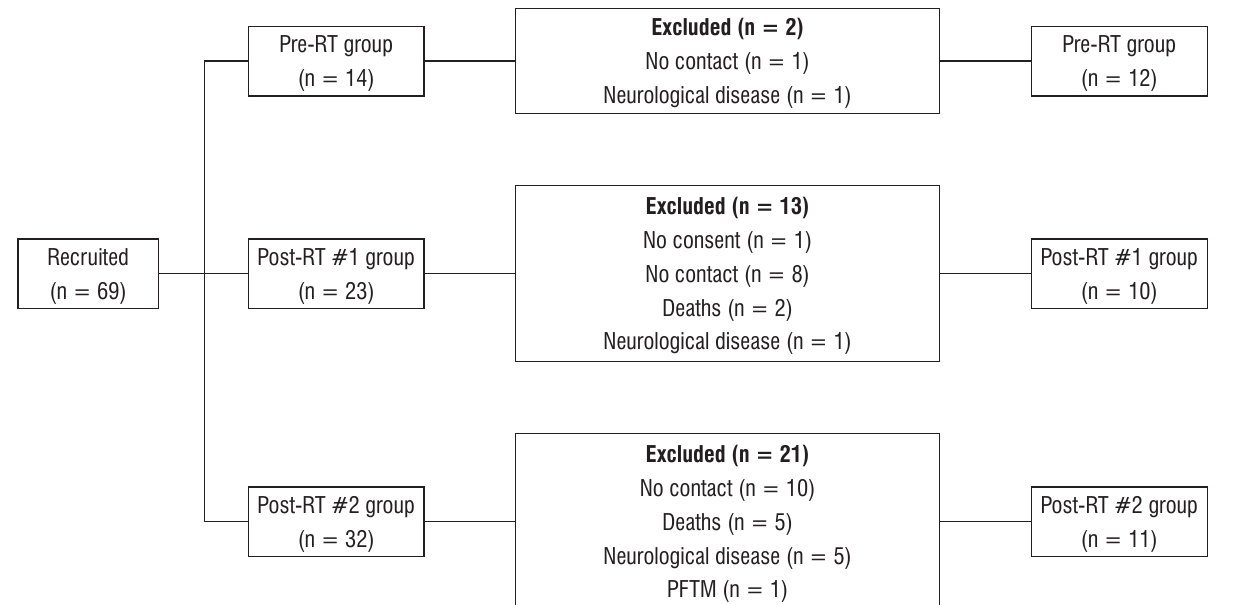
Figure 1 - Flow chart of recruited and excluded patients in the study, separated by groups. Note: PFMT: pelvic floor muscles training; RT,